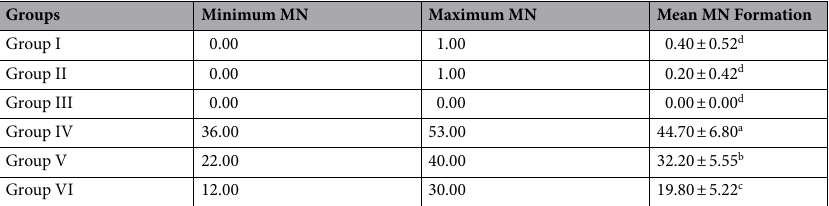
Table 3. Effects of penoxsulam on MN formation and protective role of BBE. Group I: tap water (control), Group II: 25 mg/L BBE, Group III: 50 mg/L BBE, Group IV: 20 μg/L penoxsulam, Group V: significant (P < 0.05).